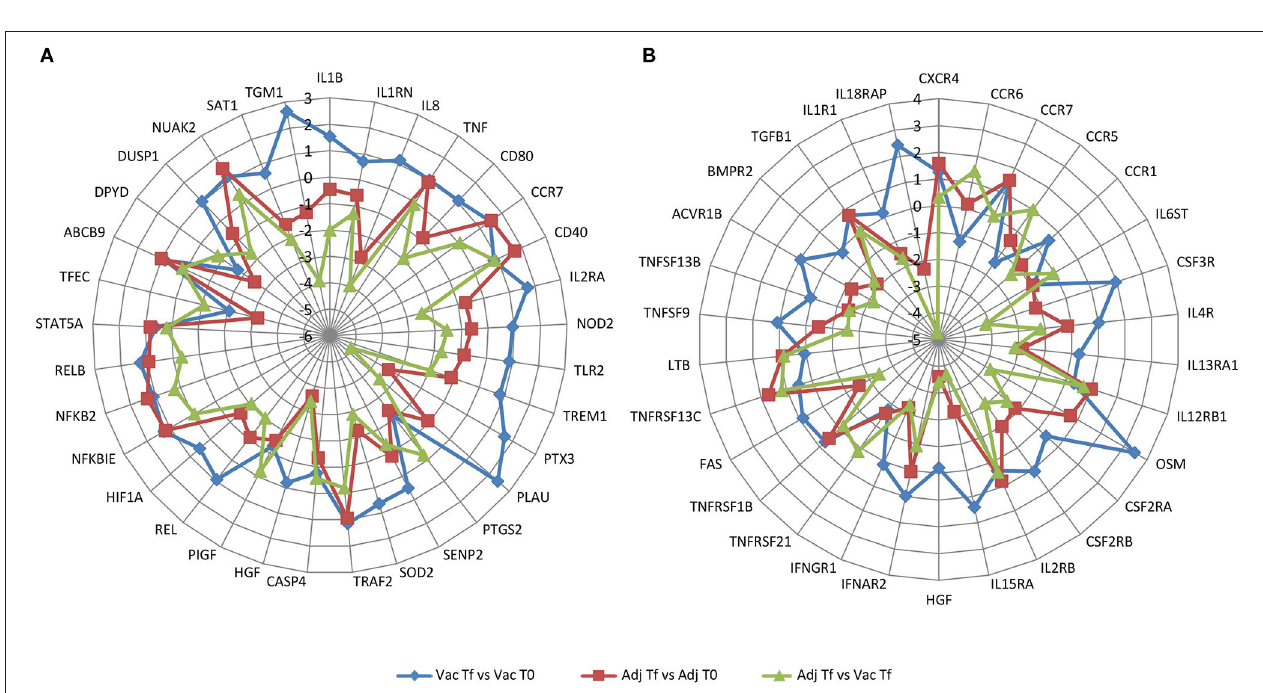
FIGURE 7 | Enriched KEGG pathways in the Adj Tf vs. Vac Tf comparison in DAVID with EASE Score (a modified Fisher’s exact test) and Benjamini-Hochberg False Discovery Rate correction. Black boxes represent different pathways and the points the differentially expressed genes in each pathway, up-regulated ones in red and down-regulated ones in blue.